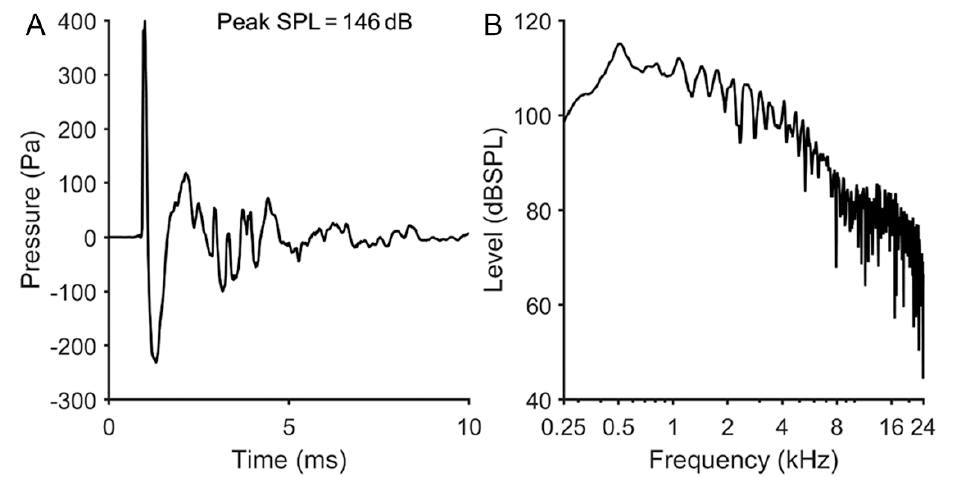
Figure 1. Example of impulse noise waveforms measured at the animal’s head. ( A ) Pressure-time waveform obtained from one impulse at a peak pressure of 146 dB SPL. ( B ) Energy spectrum of the 10 ms pressure-time waveform shown in ( A ).